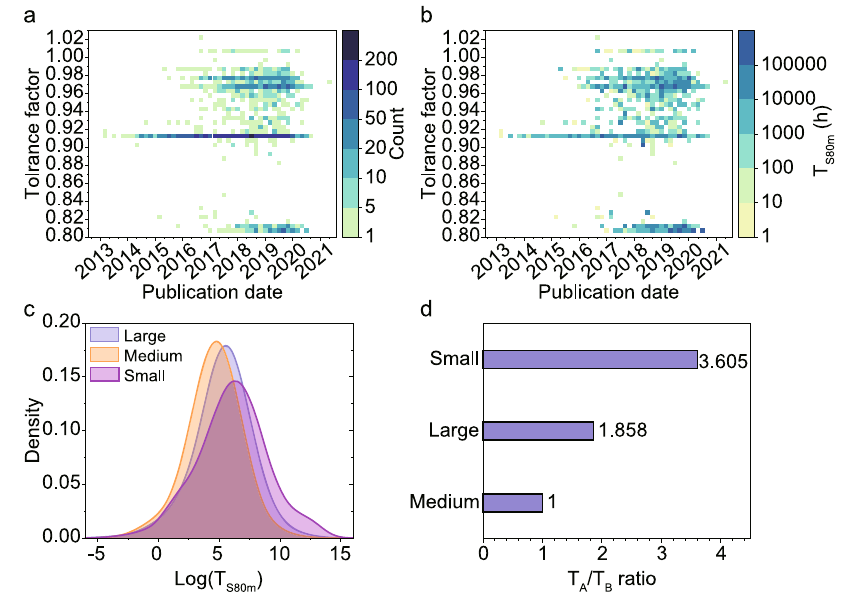
α >0.95; medium, i.e., samplewith 0.85< α <0.95;small, i.e., samplewith α <0.85.) factor regions, where the ratio of the medium tolerance factors is set to